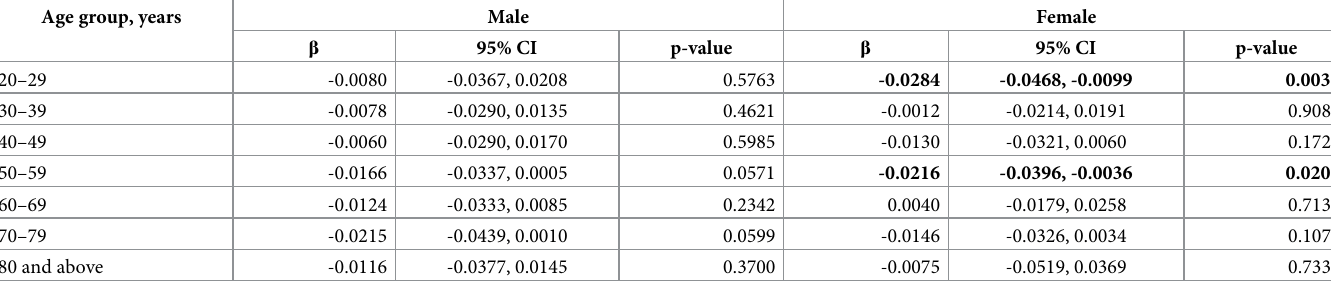
Table 3. Decline in telomere length by gender, across age groups, NHANES 1999–2002.